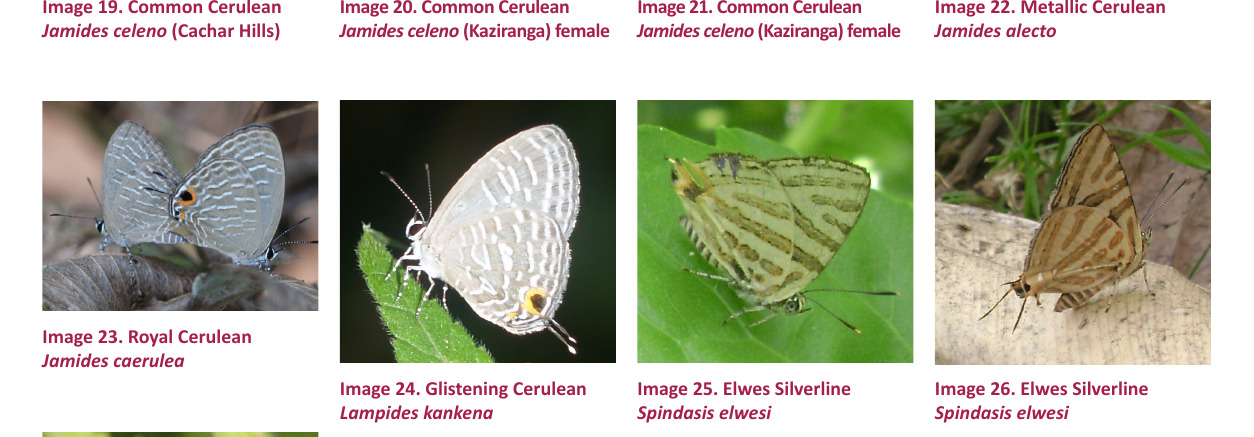
Image 21. Common Cerulean Jamides celeno (Kaziranga) female